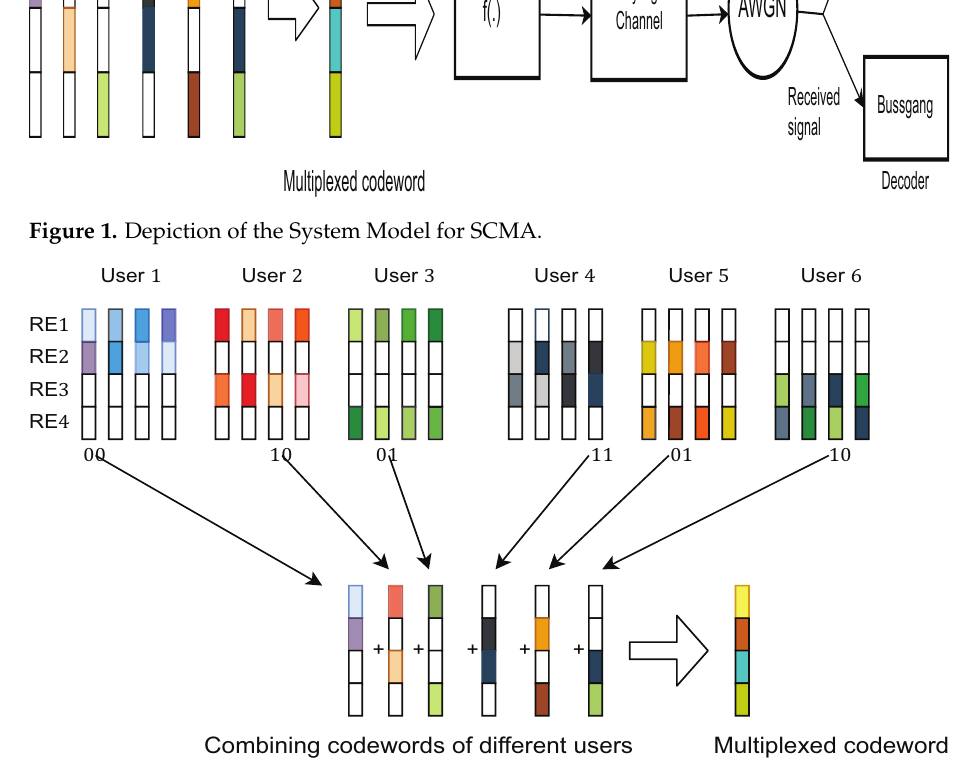
Figure 2. Depiction of the overlapping of codewords for different